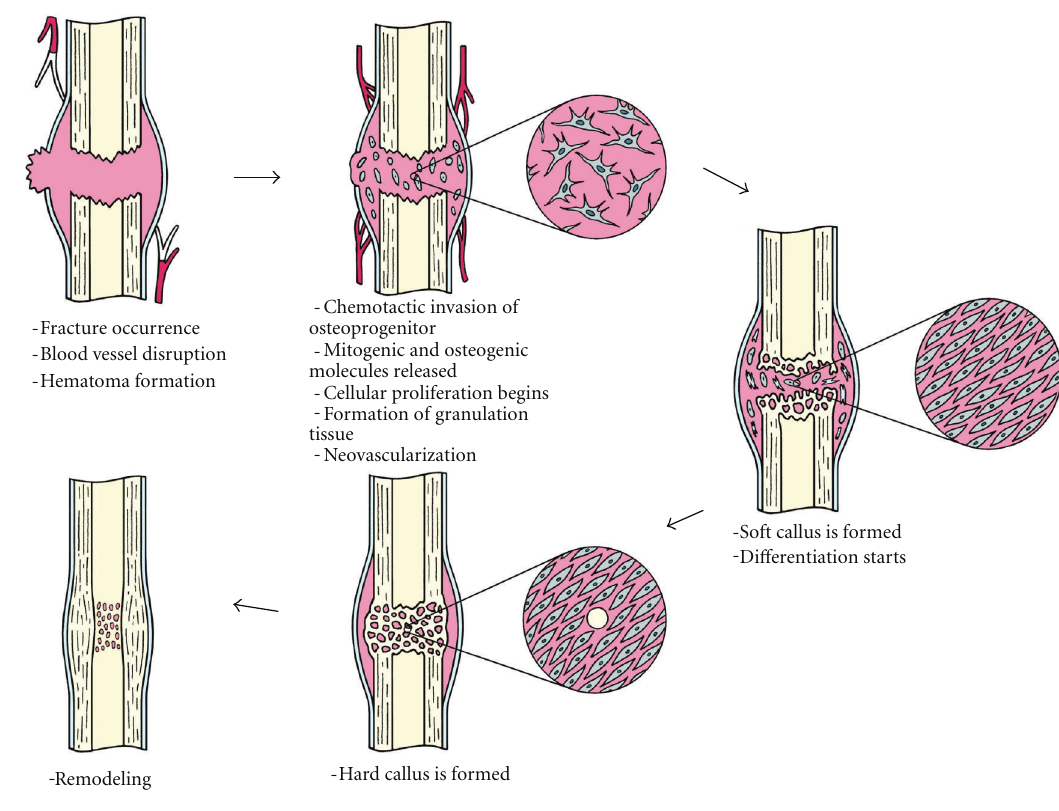
Figure 1: The fracture healing